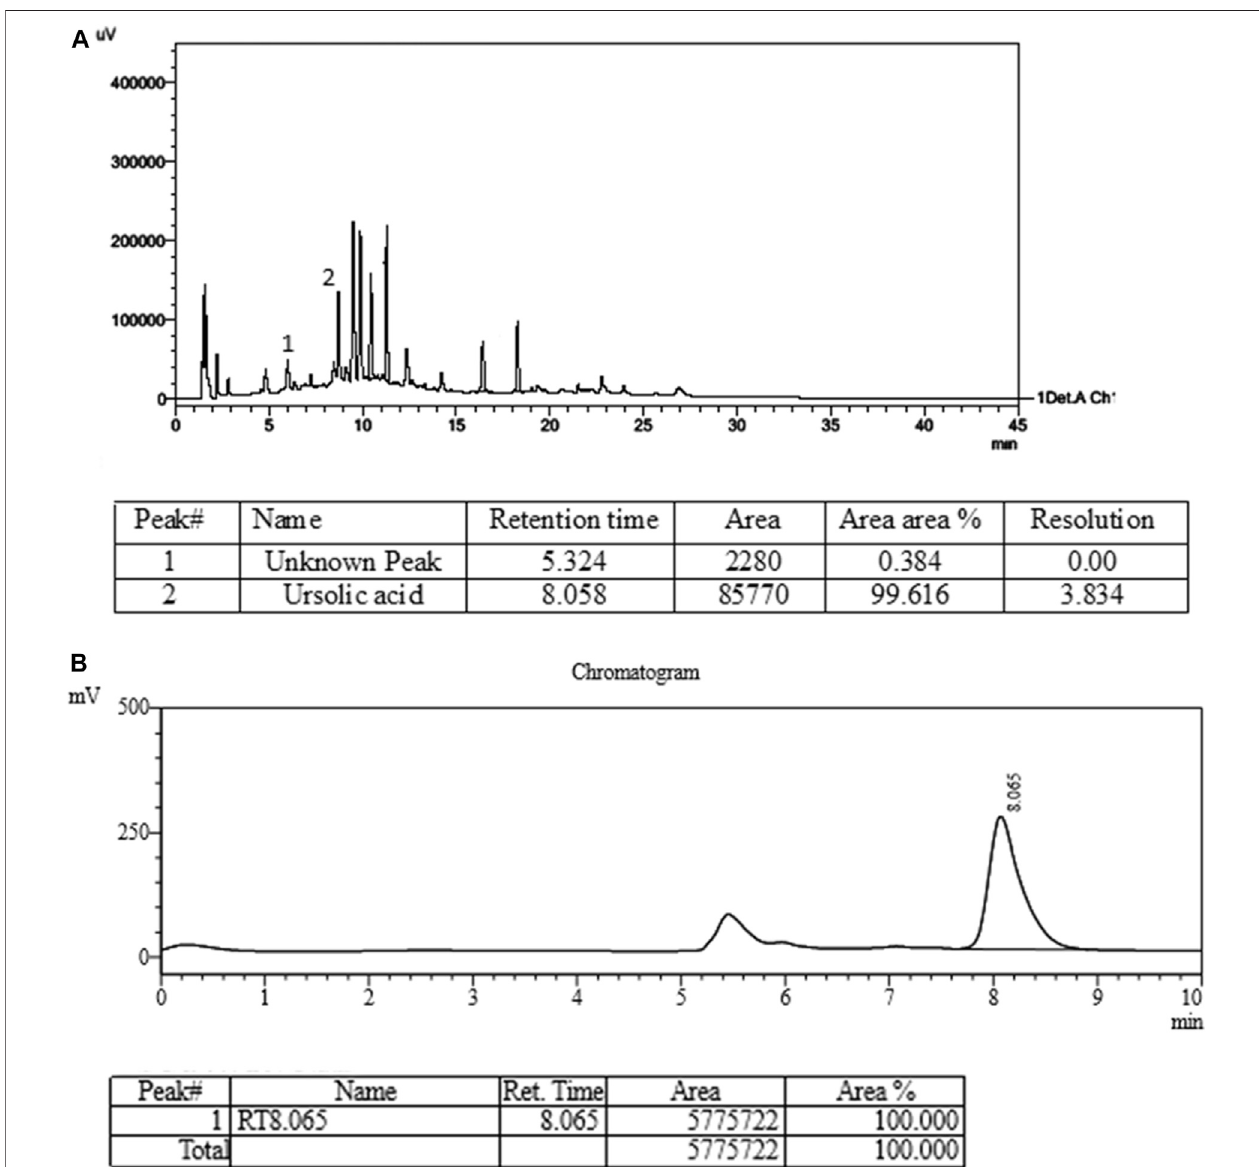
FIGURE 3 | HPLC chromatogram of plant extract (A) and ursolic acid standard (B) .